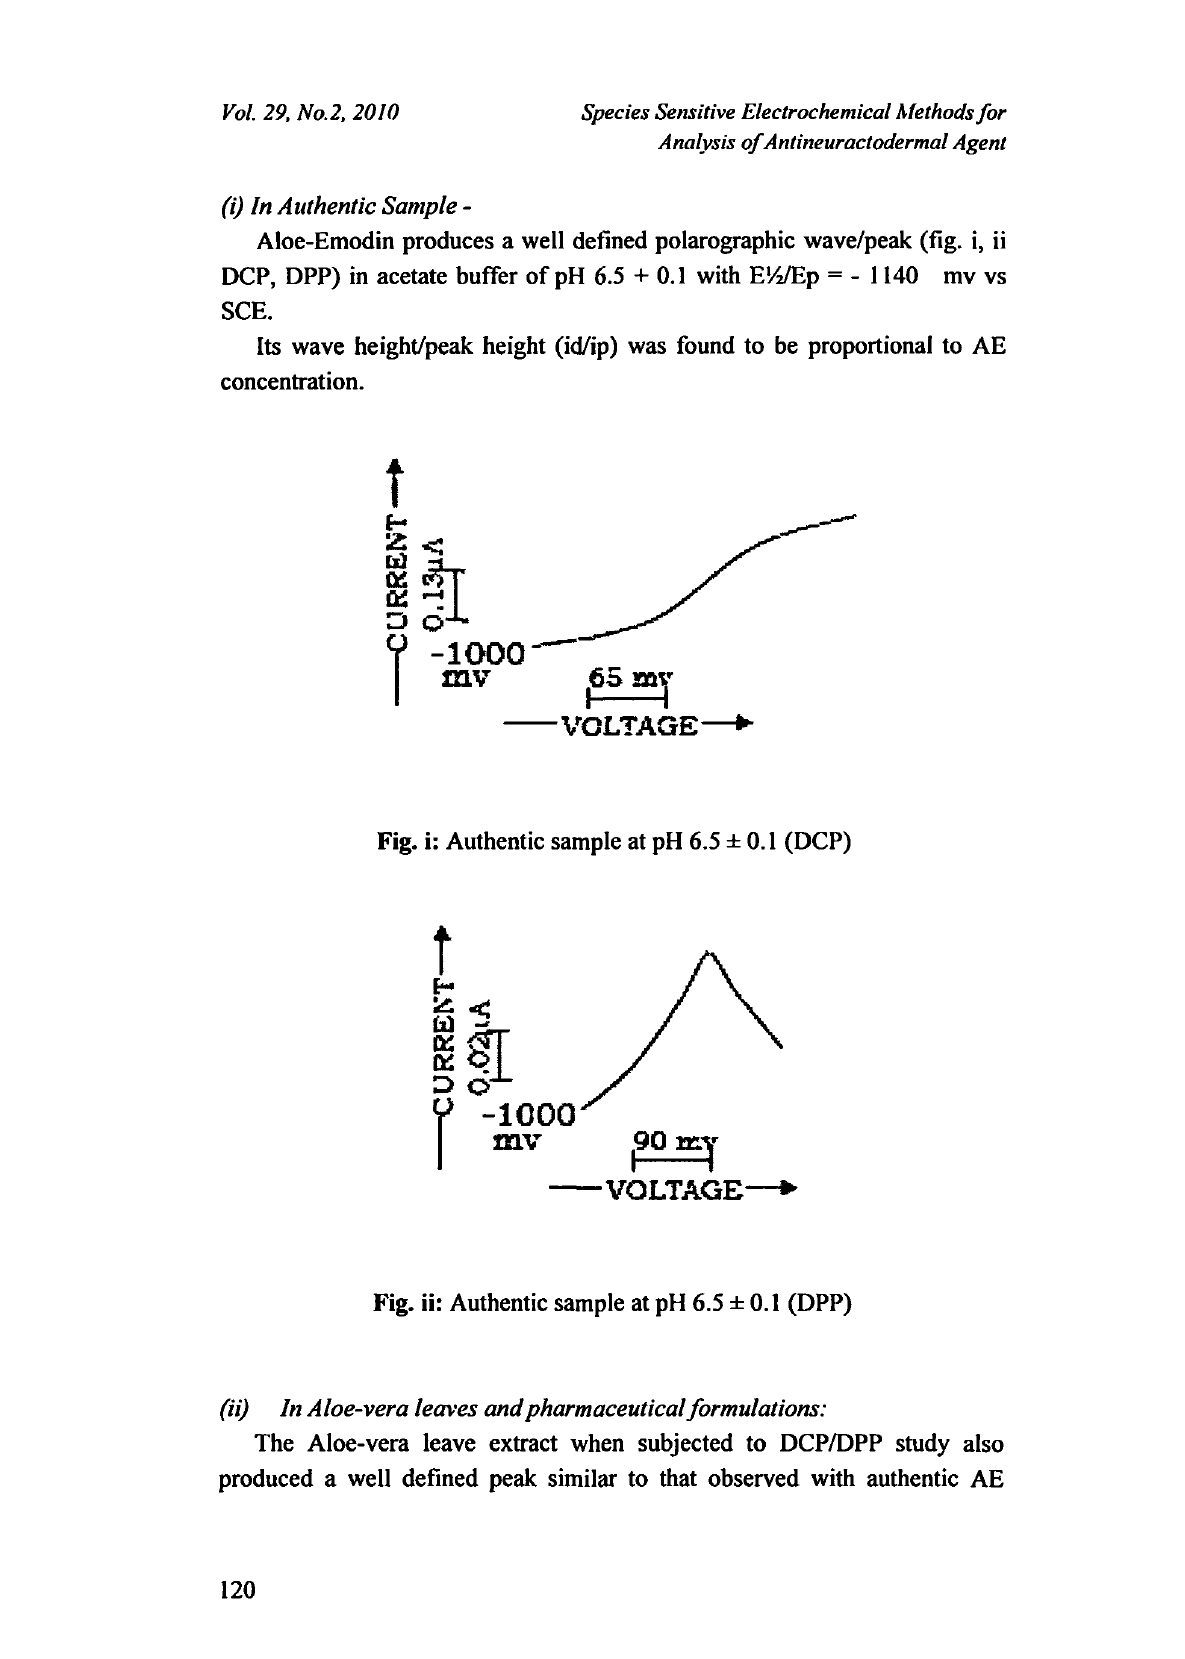
Fig. ii: Authentic sample at pH 6.5 ± 0.1